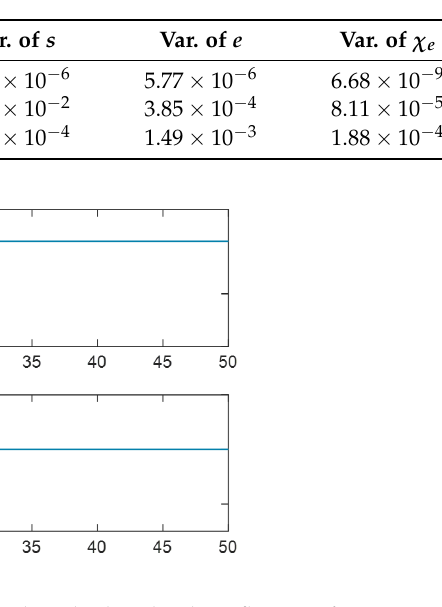
Figure 6. The tracking errors with different methods under the influence of CON-C. Table 3. The specific data of tracking errors under CON-C.